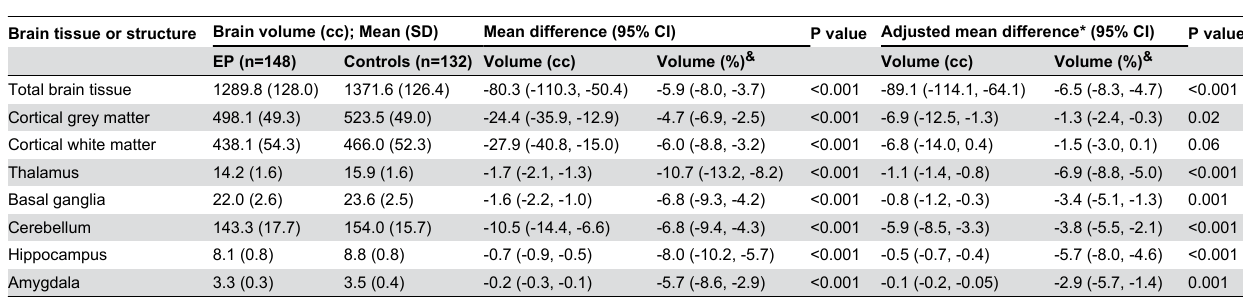
Table 2. Brain volumes in EP adolescents compared with controls.